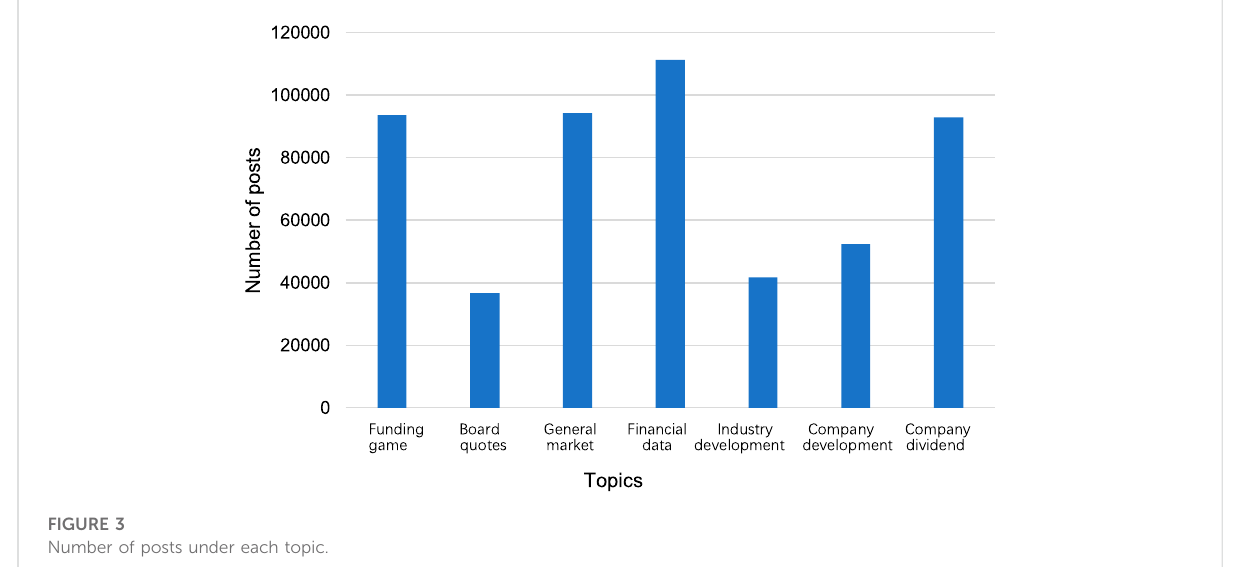
FIGURE 3 Number of posts under each topic.